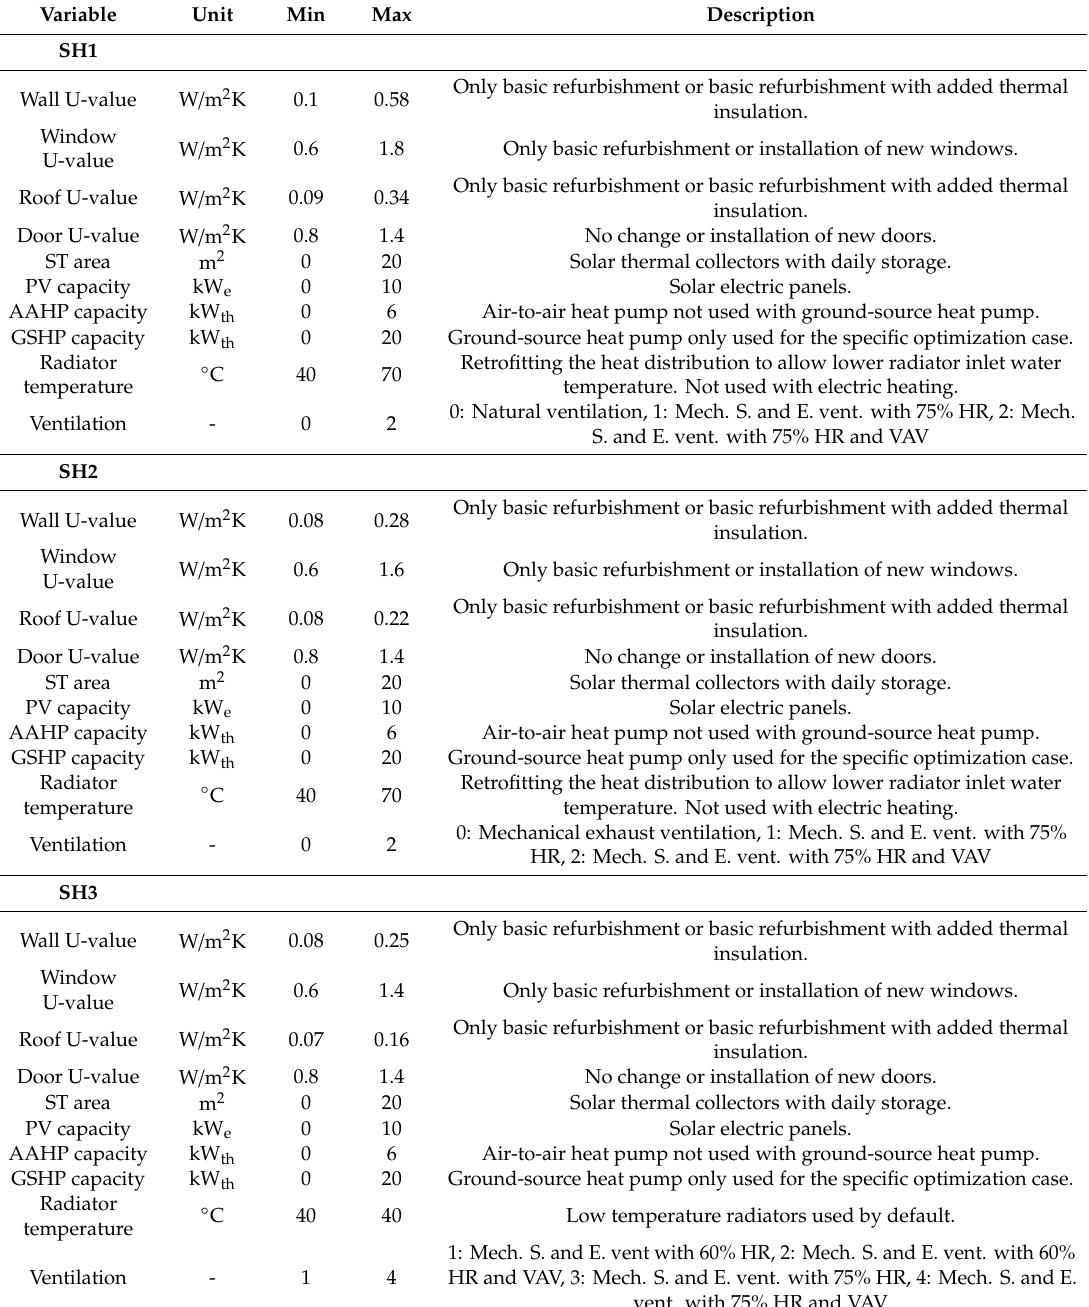
Table 10. Optimization parameters for all building age